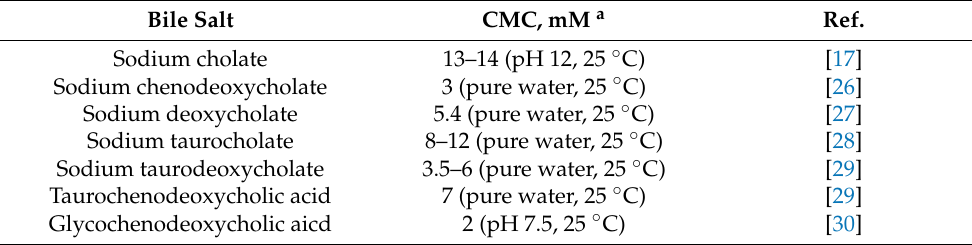
Table 1. Bile acids commonly utilized in MEKC from 2000 to 2020, their CMC and references. Bile